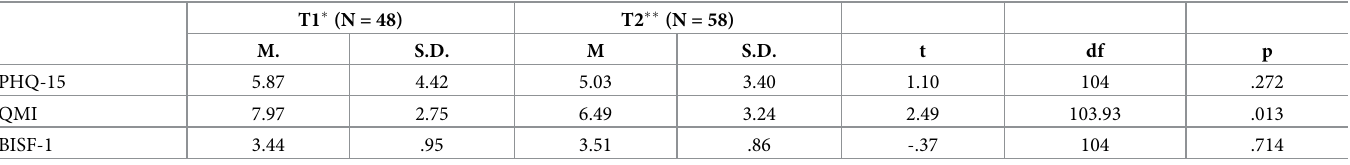
Table 5. Results from the independent-samples t-tests based on the period in which the relationship started. T1 � (N =